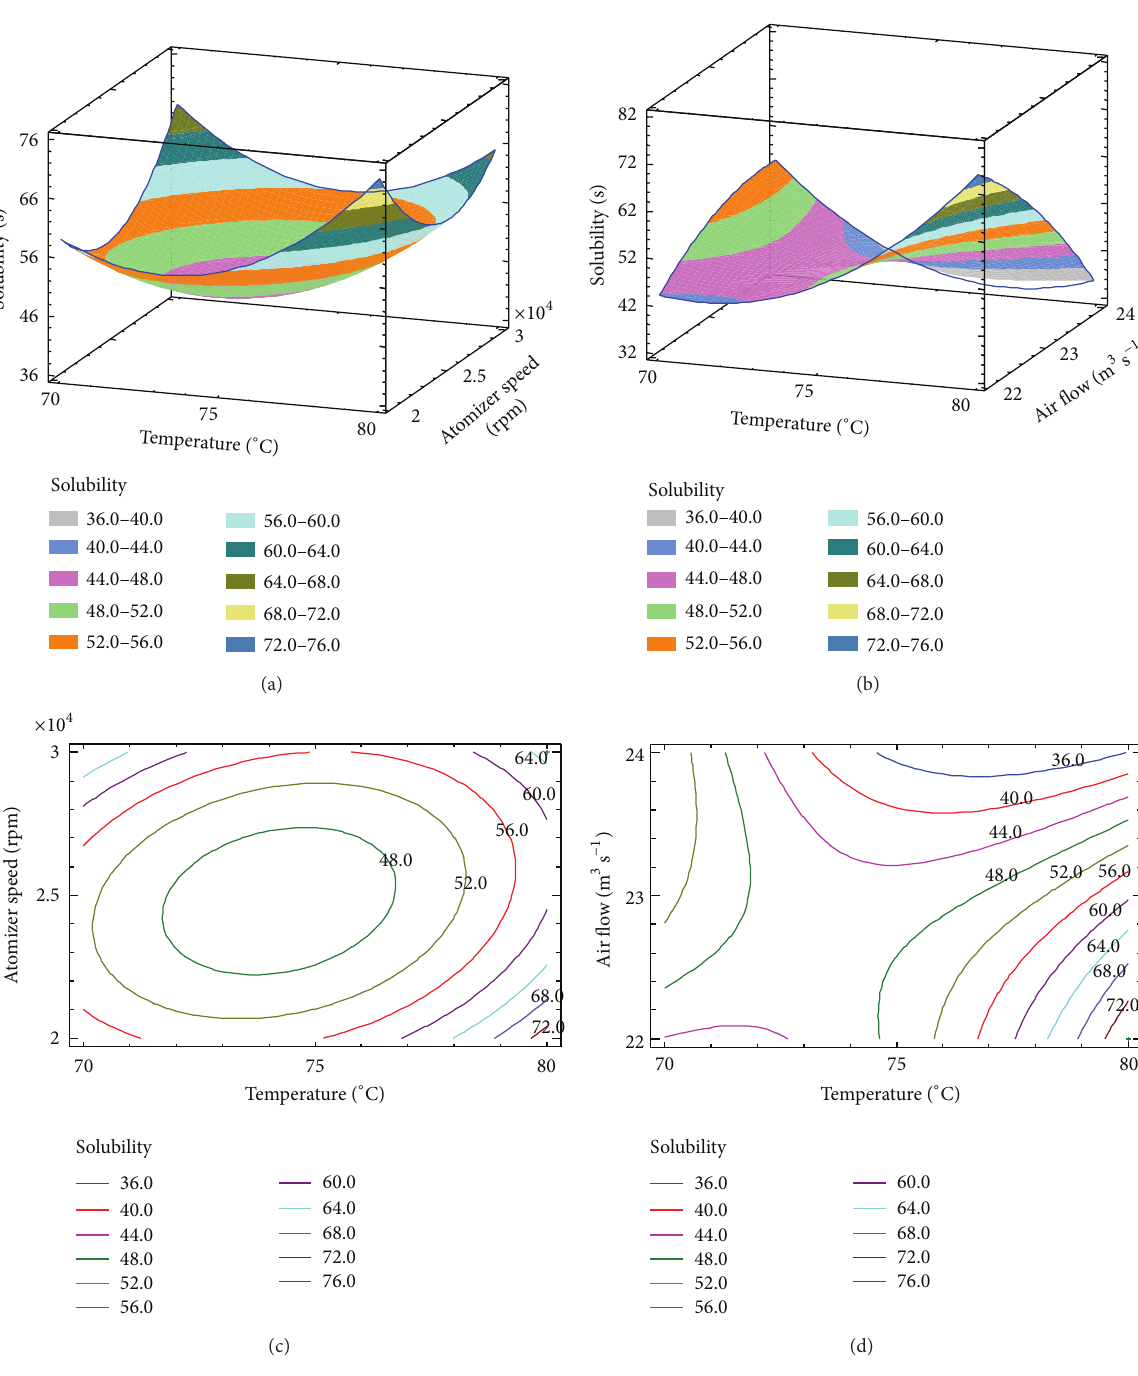
Figure 2: Surface plot showing (a) the effect of temperature and atomizer speed at an air flow of 0.215 m 3 s −1 and (b) the effect of temperature and air flow at an atomizer speed of 25000 rpm on the powder solubility